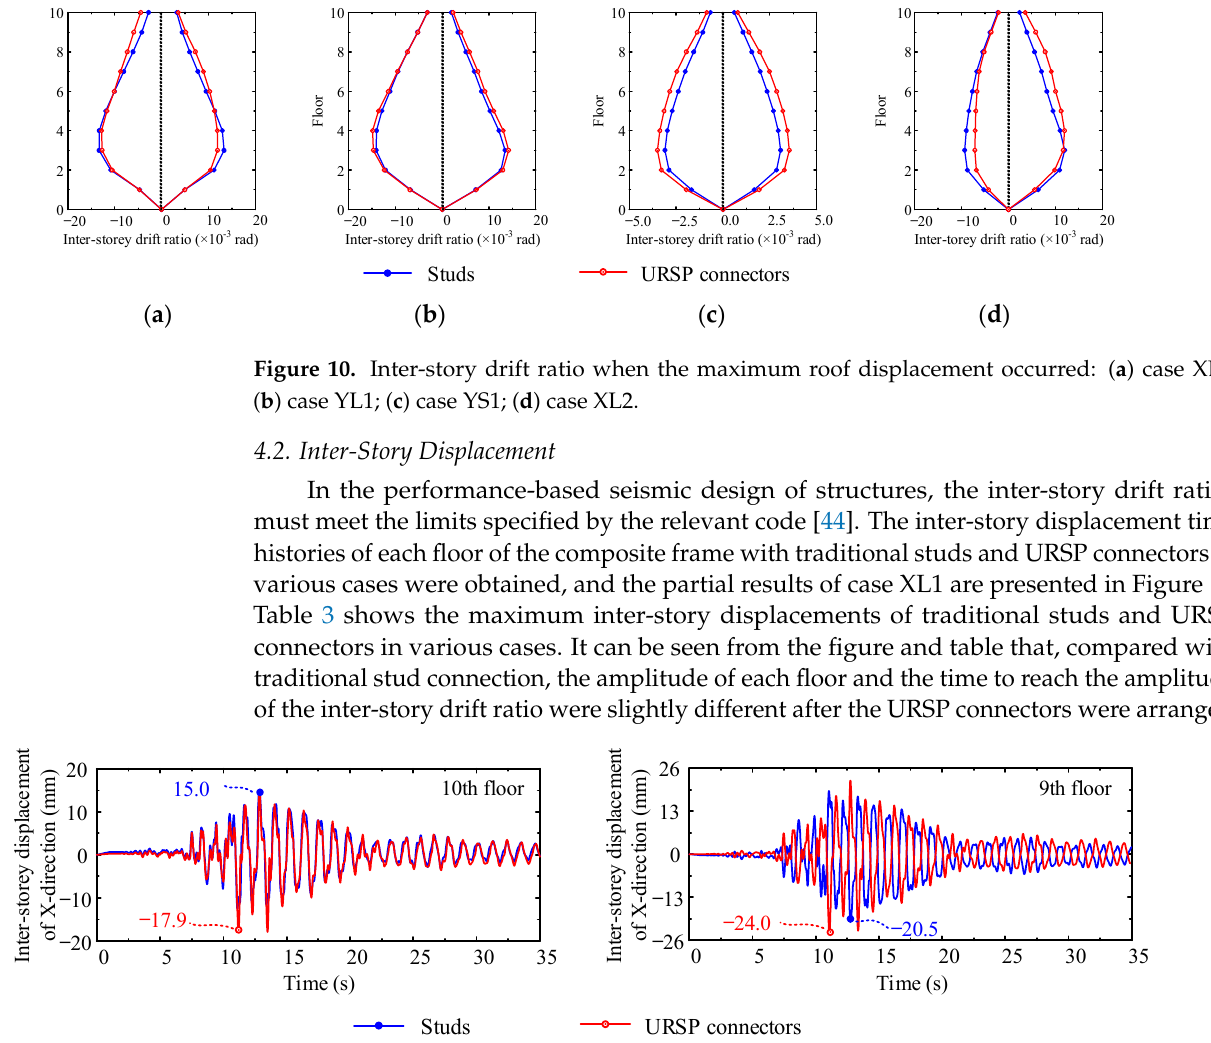
Figure 9. Lateral displacement when the maximum roof displacement occurred: ( a ) case XL1; ( b ) case YL1; ( c ) case YS1; ( d ) case XL2.